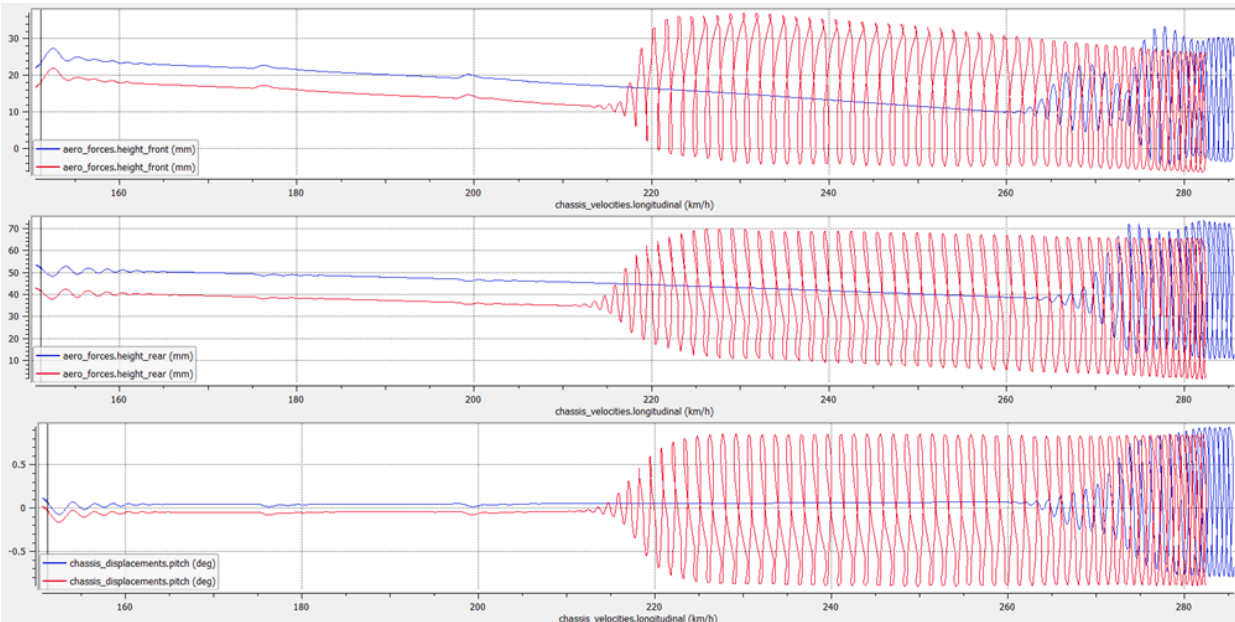
Figure 26. Static ride height variations FRHS +5 mm, RRHS +10 mm (#3, blue): porpoising is remarkably delayed. In this plot FRH ( top ), RRH ( center ), and pitch variation ( bottom ) are shown.